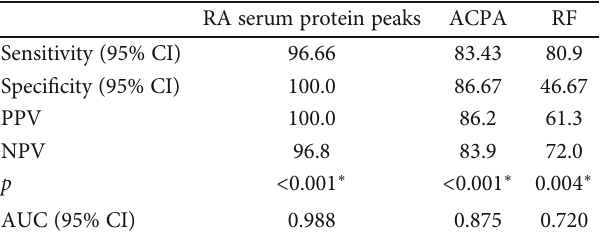
Table 4: Comparison of training set data with other laboratory markers for diagnosing